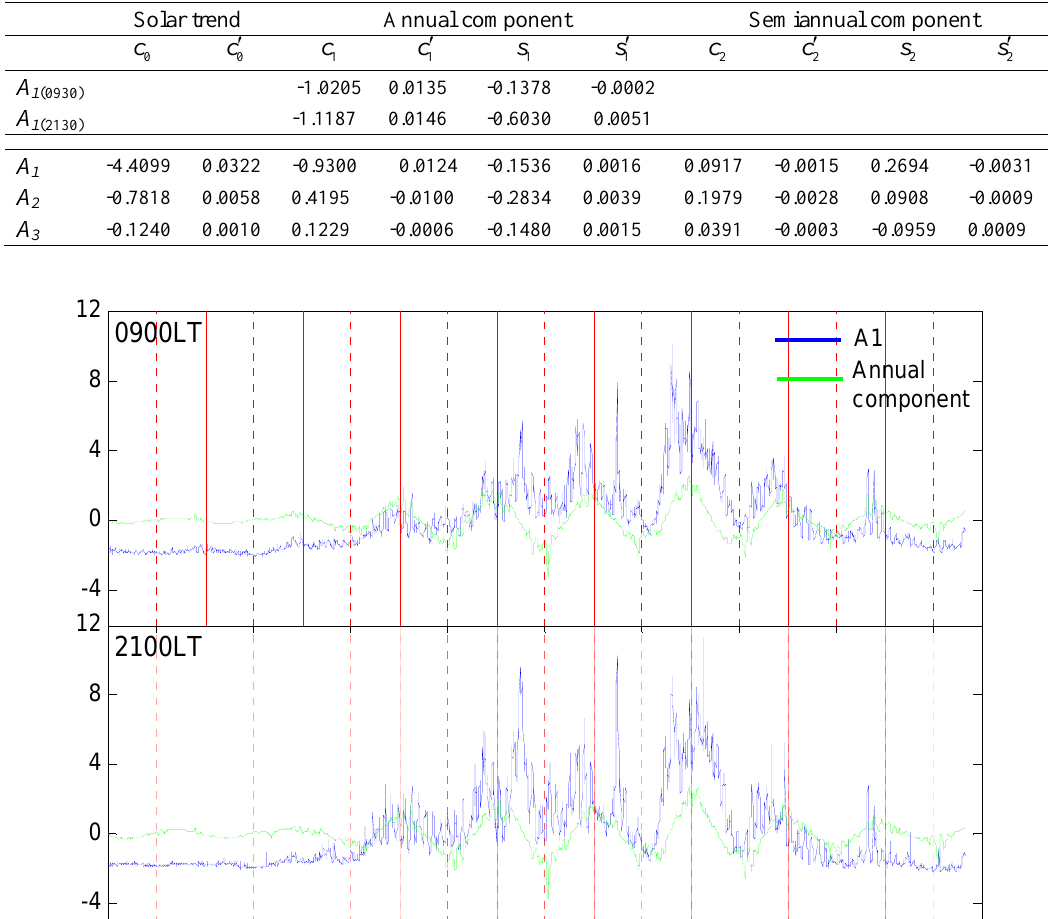
coefficient and its associated annual component (derived from equation 3) Figure 8. A 1